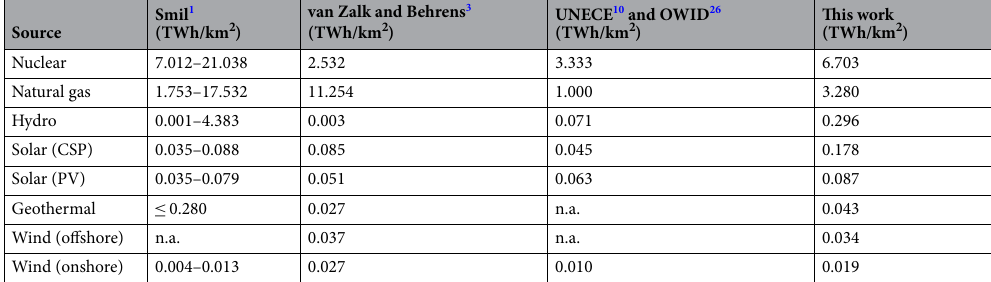
Table 17. Comparison of the annual energy densities of the different power sources found in the literature and comparison to the mean values found in the population studies (please refer to Table 16) of this work. The other studies also represent the generation facility’s spatial extent via the total area requirement. Smil provides lower and upper limits, while van Zalk and Behrens, United Nations Economic Commission for Europe (UNECE) and Our World in Data (OWID) specify mean values.